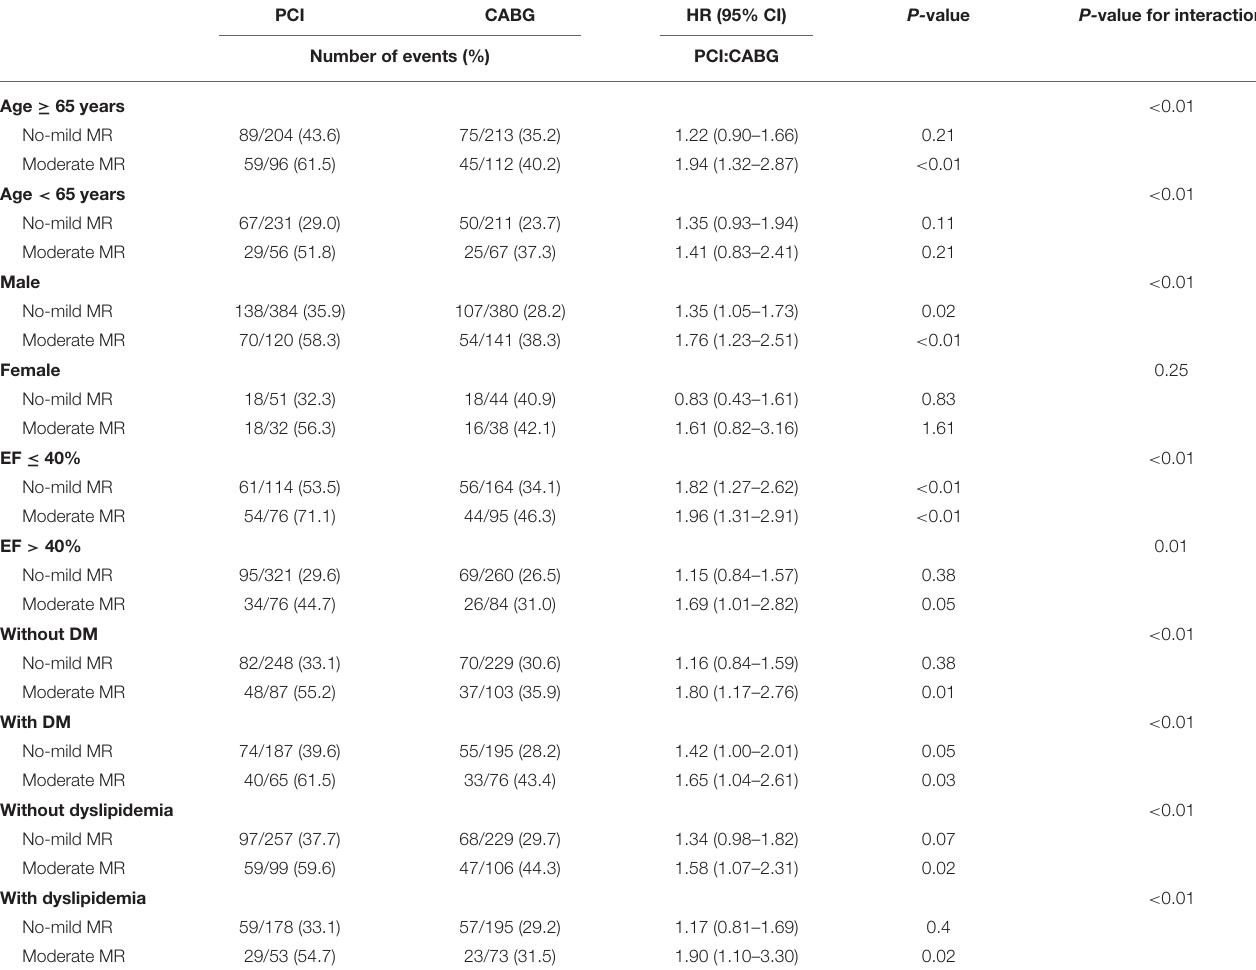
TABLE 4 | Subgroup analyses of the primary endpoint in patients stratified by the severity of MR.